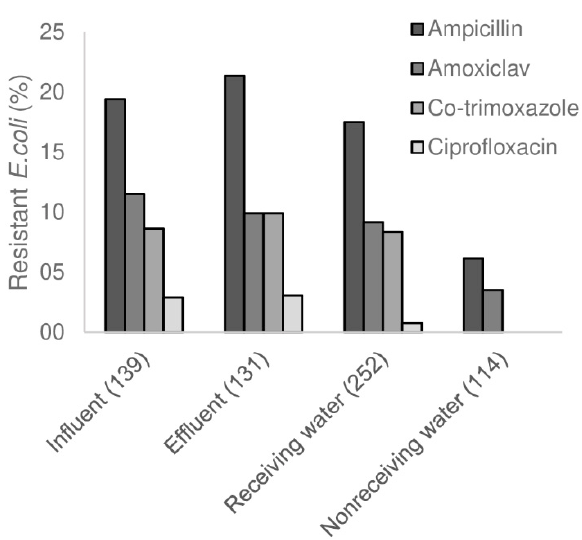
Figure 5. Antimicrobial resistance in the WWTP and surface water. The percentage of resistant E. coli against four antimicrobials in the WWTP (influent and effluent), receiving surface water and the control surface water are shown. The number of isolates tested per location are shown in brackets.